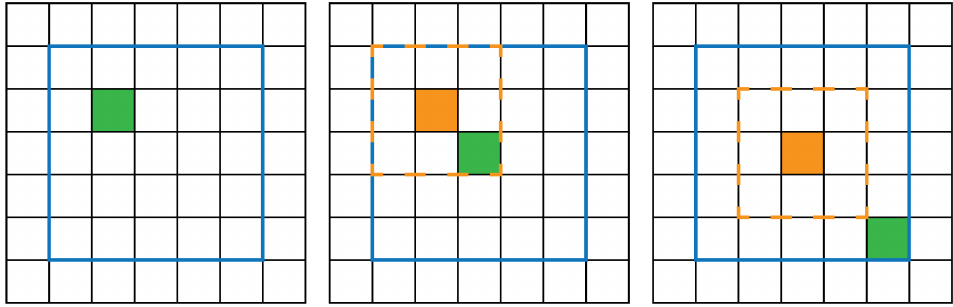
Figure 5. Key point’s detection example: In the left image, a key point (green square) is detected for a given pixel, inside the bounding box that delimit the face of interest (blue box); in the center image, at the following frame, a key point is detected at one pixel distance respect to the previous one (the orange square), thus it is considered the same key point because it inside the 1-pixel bounding box (orange dashed box); in the right image, at the following frame, a key point is detected but it is outside of the 1-pixel bounding box of the previous frame, thus it is considered as a new key